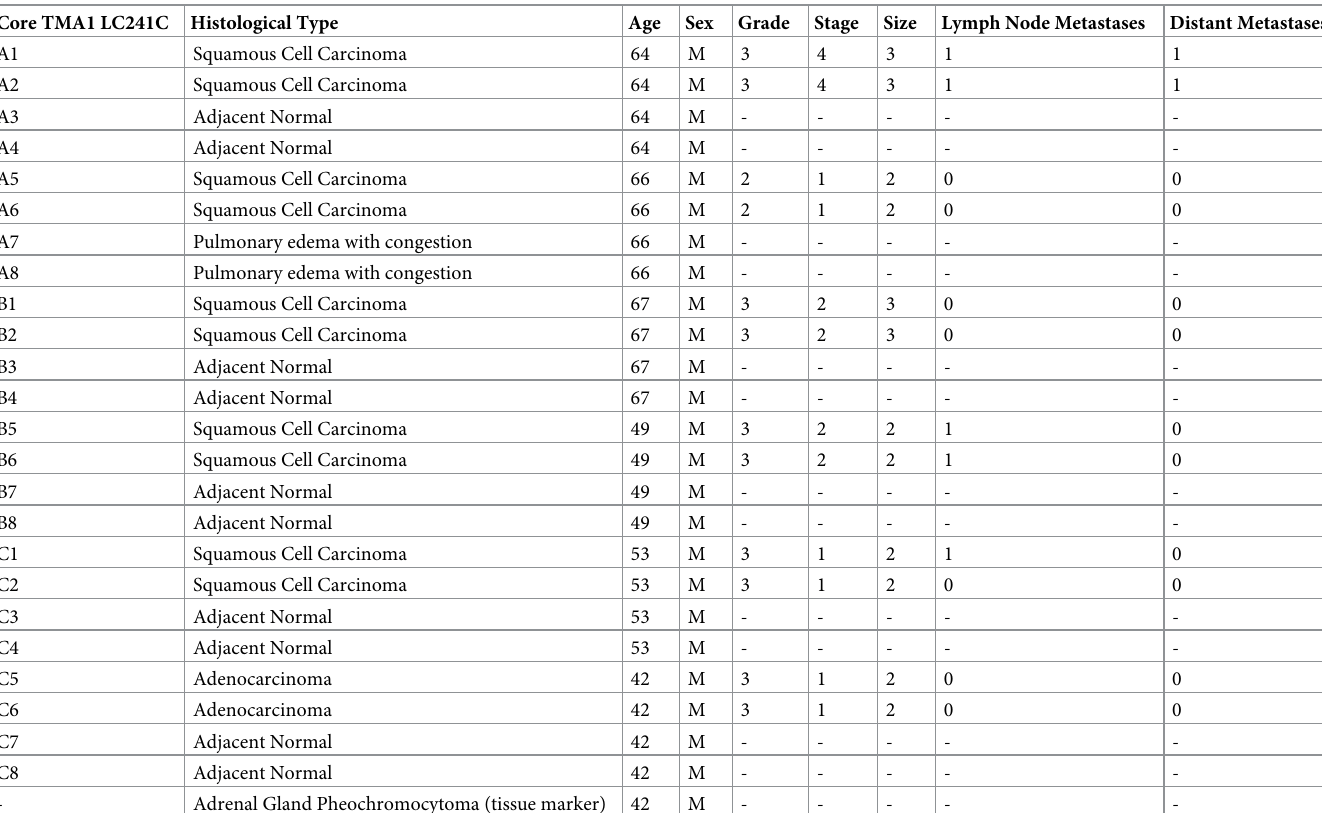
Table 1. Complete description of TMA